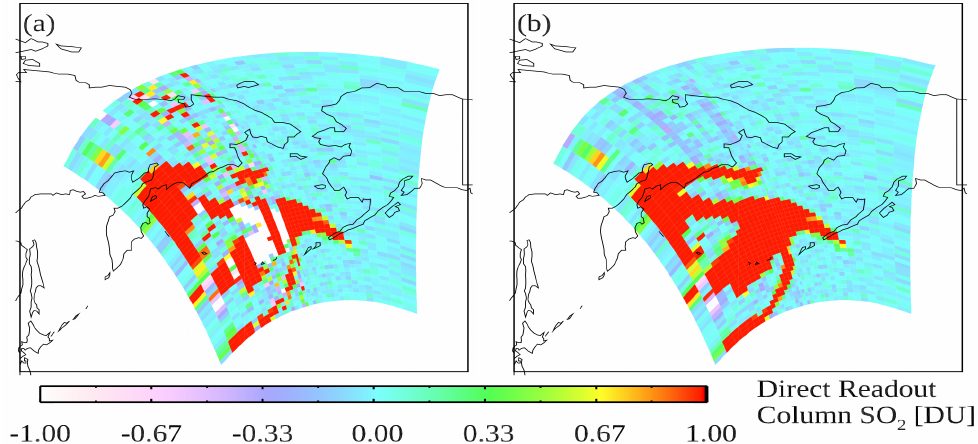
Figure 1. ( a ) The previous version of the science processing algorithm (SPA) for UV-based OMPS SO 2 retrievals had false positive artifacts and missed SO 2 (white pixels) for large eruptions such as the 2019 Raikoke eruption. ( b ) The updated SPA designed for DR retrievals mitigates these issues, leading to overall better data quality. Quantitative SO 2 column density data are expressed in Dobson units (1 DU = 2.69 × 10 16 molecules of SO 2 per cm 2